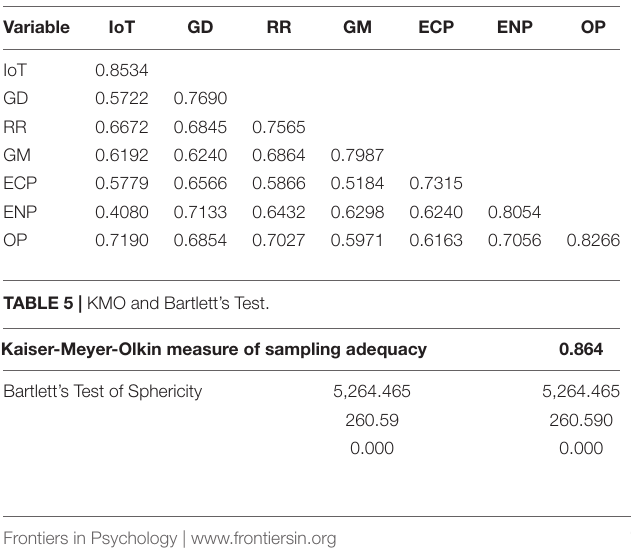
TABLE 4 | Results of discriminant validity.